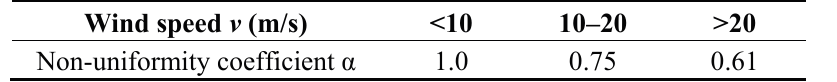
Table 2. Non-uniformity coefficient of wind speed ( α ) for 500-kV transmission